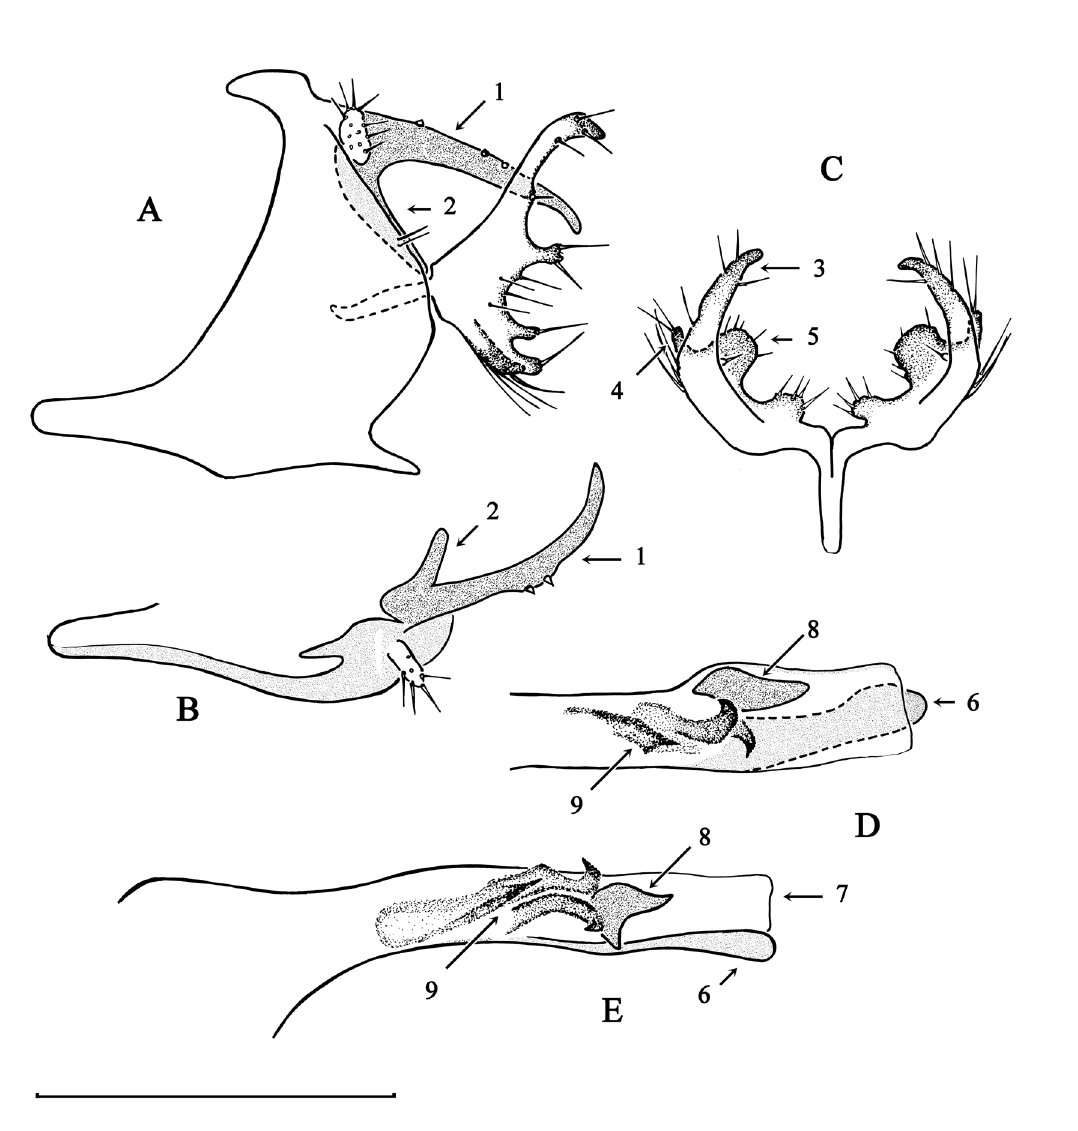
Fig. 2. Chimarra lehibemavo sp. nov. A–B . Abdominal segments IX and X. A . Lateral view. B . Dorsal view (partim) . C . Inferior appendage, dorsal view. D–E . Phallic apparatus. D . Dorsal view. E . Lateral view. 1 = Lateral lobe of tergum X, dorsal branch. 2 = Lateral lobe of tergum X, ventral branch. 3 = Inferior appendage, dorsal branch. 4 = Inferior appendage, ventral branch. 5 = Inferior appendage, internal lobe. 6 = Phallotheca, ventral lamina. 7 = Phallotheca, dorsal lamina. 8 = Phallotheca, internal sclerite. 9 = Phallotheca, phallotremal sclerite. Scale bar =